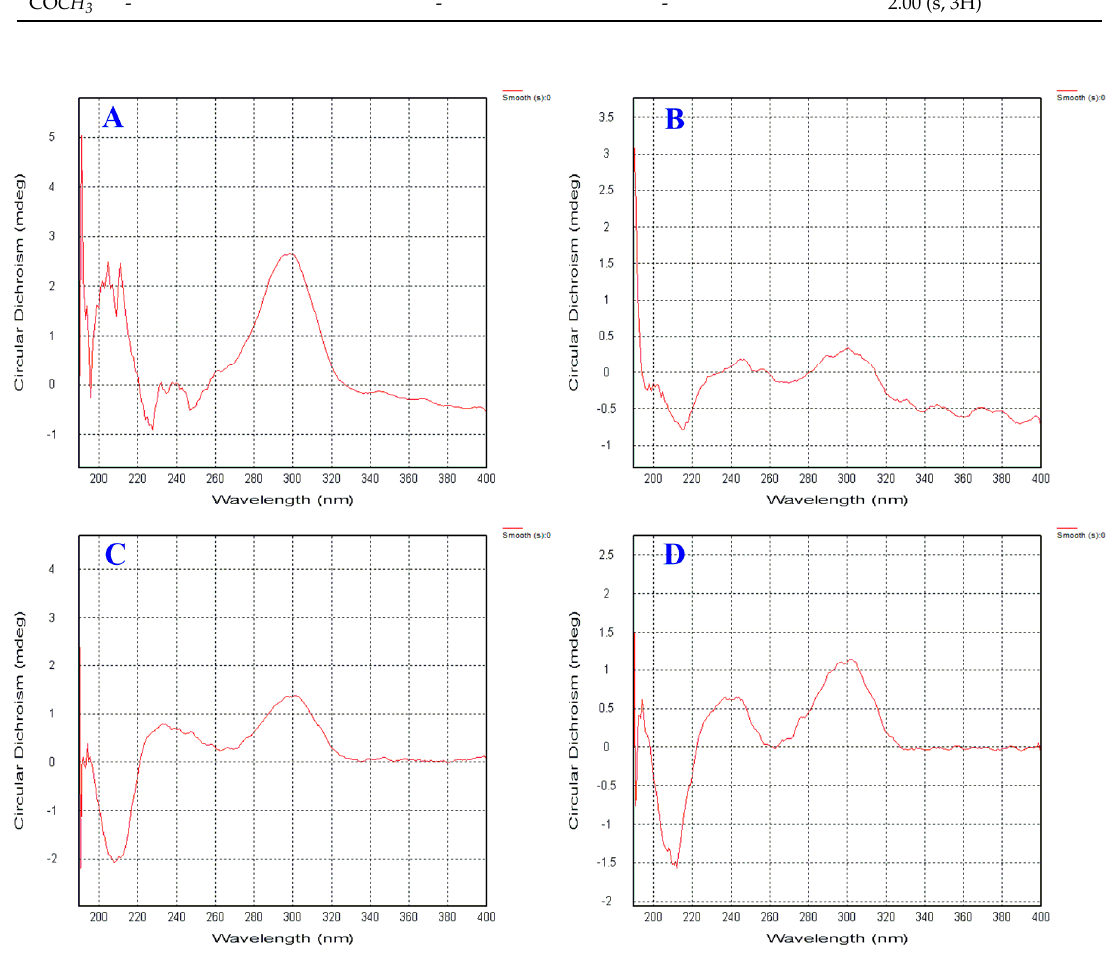
Figure 4. The CD spectra of compounds 2 – 5 . ( A for compound 2 , B for compound 3 , C for compound 4 and D for compound 5 ).